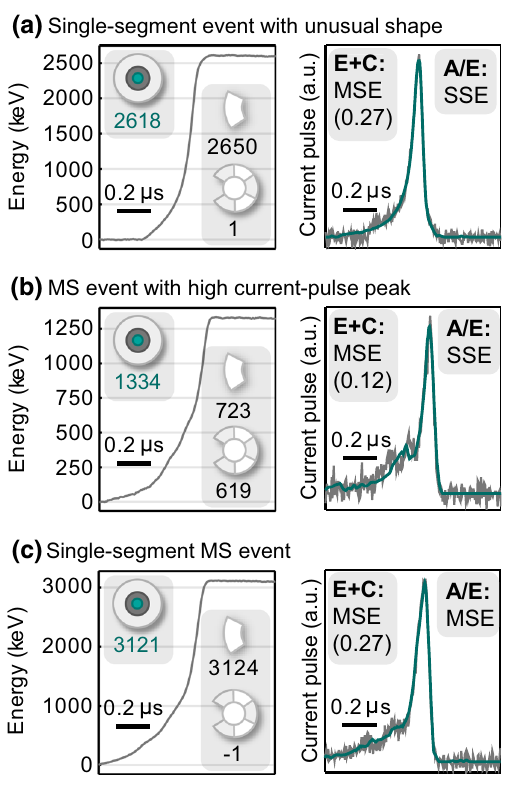
Fig. 10 Example pulses illustrating different classifications of the A / E and the encoder+classifier (E + C) methods. Left: The charge- signal waveforms, also indicating the core energy (in keV), the energy in segment 1 and the energy in other segments. Right: The preprocessed current-signal waveforms (gray curves) with their autoencoder recon- structions (green curves), indicating the event classifications and output value of the E + C network and the class predicted by the A / E